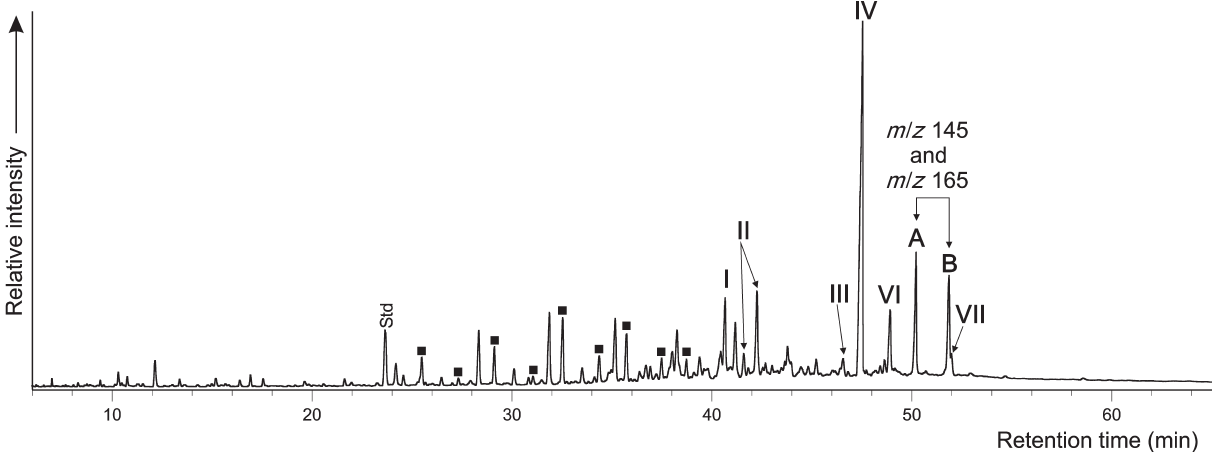
Figure 2. Gas chromatogram of the polar fraction extracted from the carbonate crust TTR-11 BS-328G-2. All alcohols were analyzed as their tri- methylsilyl derivatives. Black squares indicate straight chain alcohols. Roman numbers and letters refer to Compounds shown in Appendix